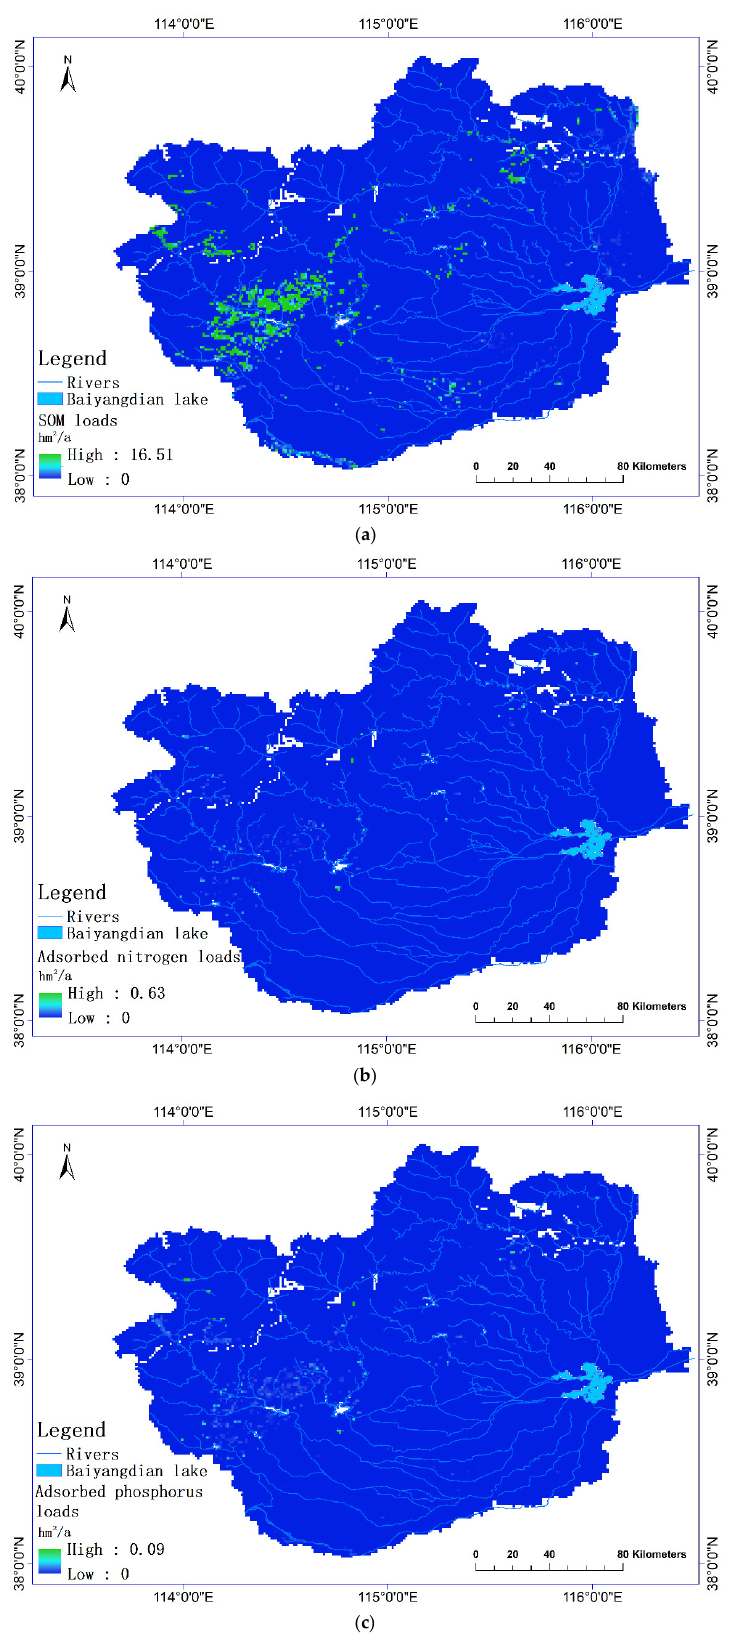
Figure 6. Adsorption pollutant loads from soil erosion in Baiyangdian lake: (( a ) Soil organic matter, ( b ) Adsorbed nitrogen, ( c ) Adsorbed phosphorus. It can be seen that the non-point source pollution load caused by soil erosion in the whole basin is generally low. The high load areas are concentrated in the Taihang Mountains, especially the upper reaches of Lilong River and Tang River. The difference between the loads of the three pollutants is mainly due to their different contents in the surface soil, generally in the order of total nitrogen > total phosphorus > soil organic matter.